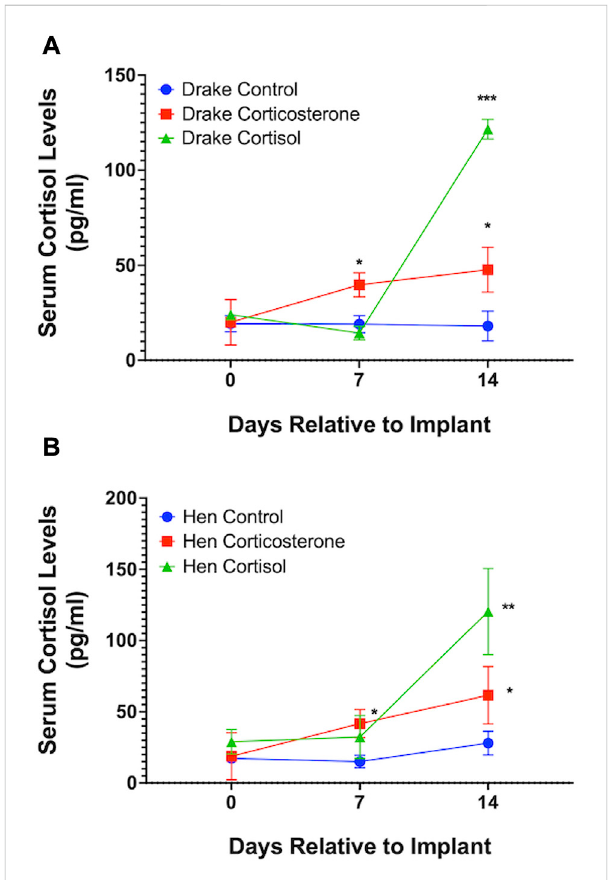
FIGURE 1 Serum cortisol levels in Drakes (A) and Hens (B) . Ducks treated with either cortisol or corticosterone showed a signi fi cant increase in serum cortisol levels compared to controls 7 and 15 days after the onset of treatment. * = p < 0.05, ** = p < 0.01, *** = p <